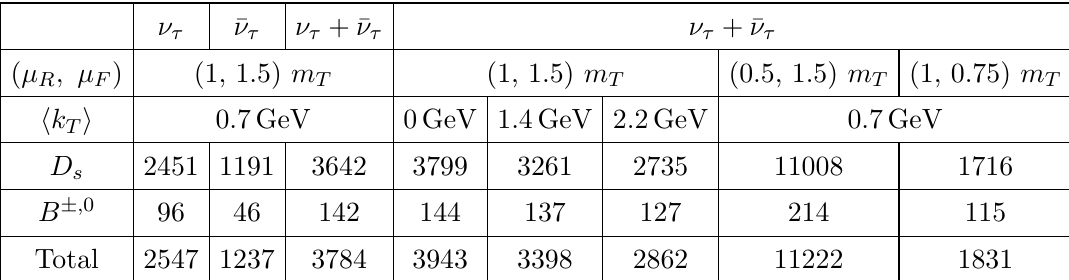
Table 1 . The charged-current event numbers for tau neutrinos and antineutrinos in 1 m length of the lead detector (equivalent to M pb ’ 35.6 ton) assuming central scales ( (cid:22) R ; (cid:22) F ) = (1 : 0 ; 1 : 5) m T in the computation of heavy-meson production in pp collisions at luminosity L = 3000 fb (cid:0) 1 . The scale combinations (0 : 5 ; 1 : 5) m T and (1 ; 0 : 75) m T give the upper and lower limits of the scale variation envelope obtained from the seven combinations of ( N R ; N F ) shown in (cid:12)gure 6.